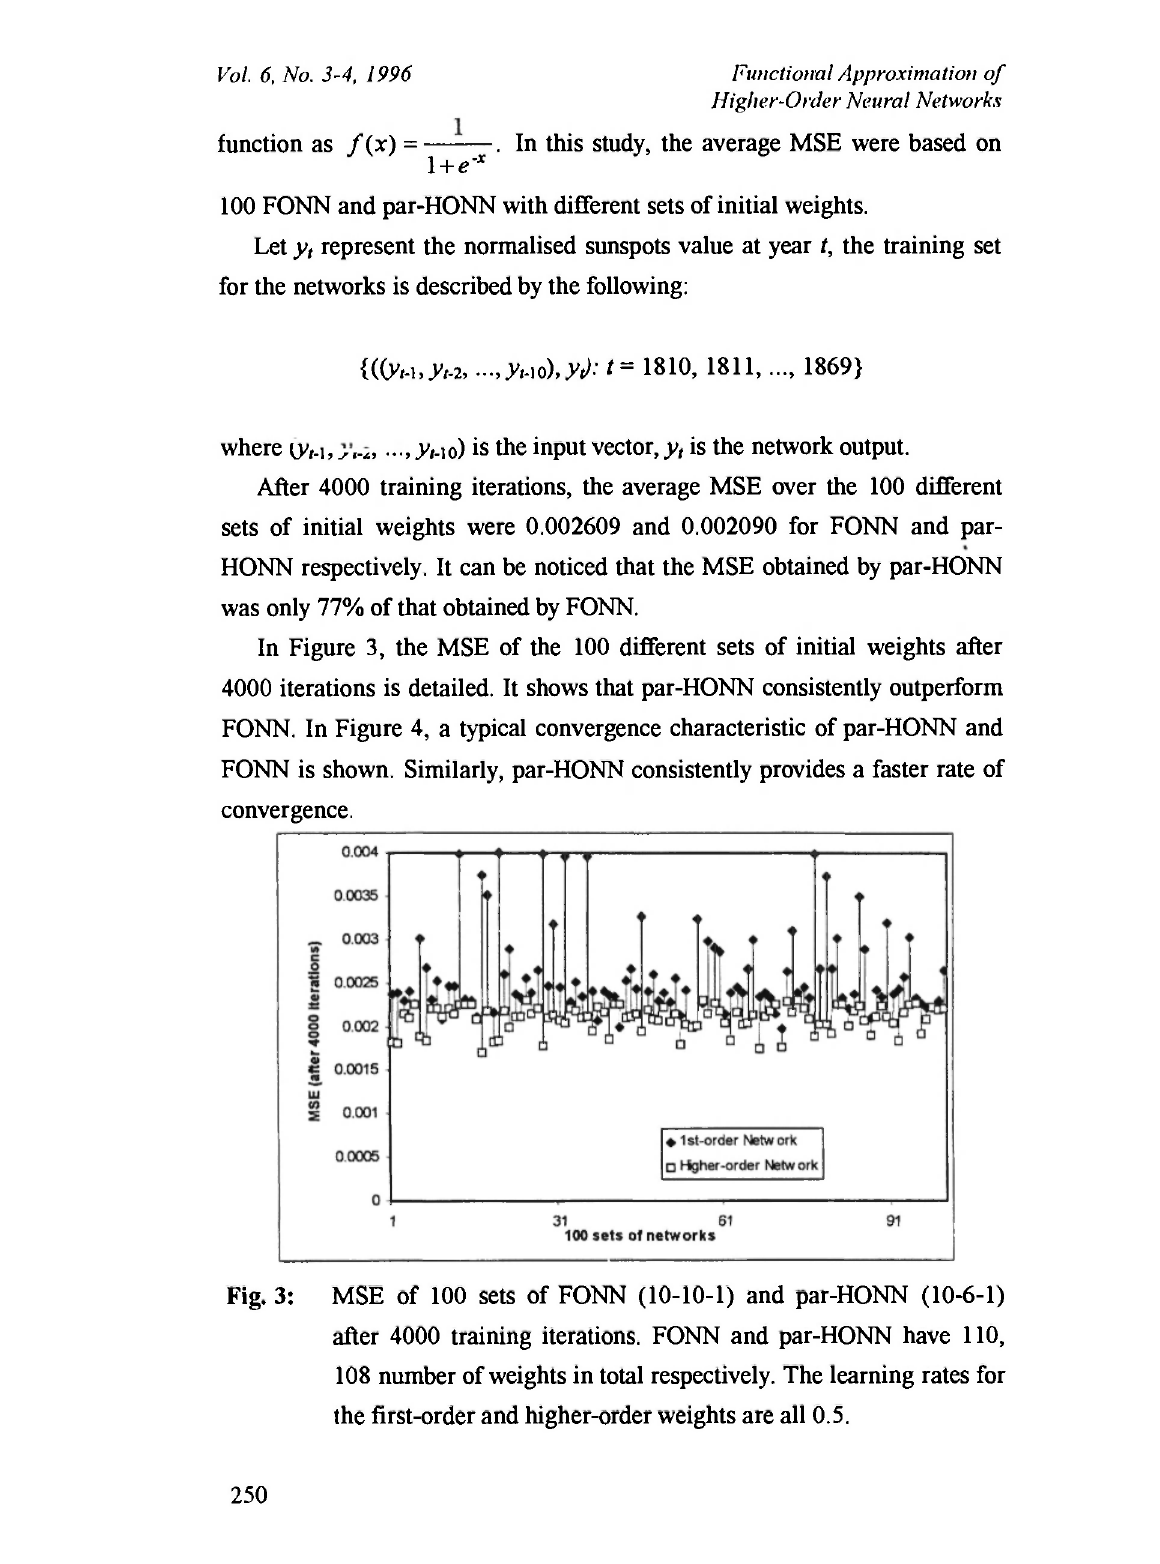
Fig. 3: MSE of 100 sets of FONN (10-10-1) and par-HONN (10-6-1) after 4000 training iterations. FONN and par-HONN have 110, 108 number of weights in total respectively. The learning rates for the first-order and higher-order weights are all